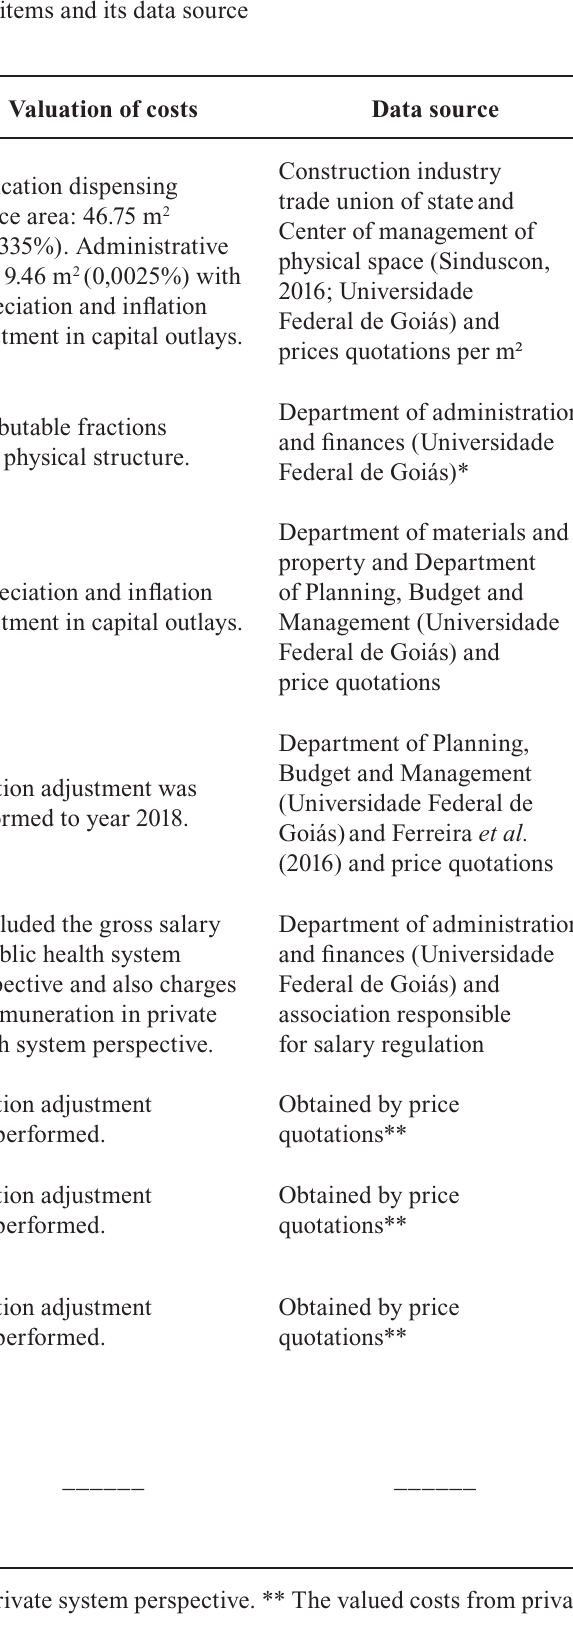
TABLE III - Measurement and valuation form from identified cost items and its data source